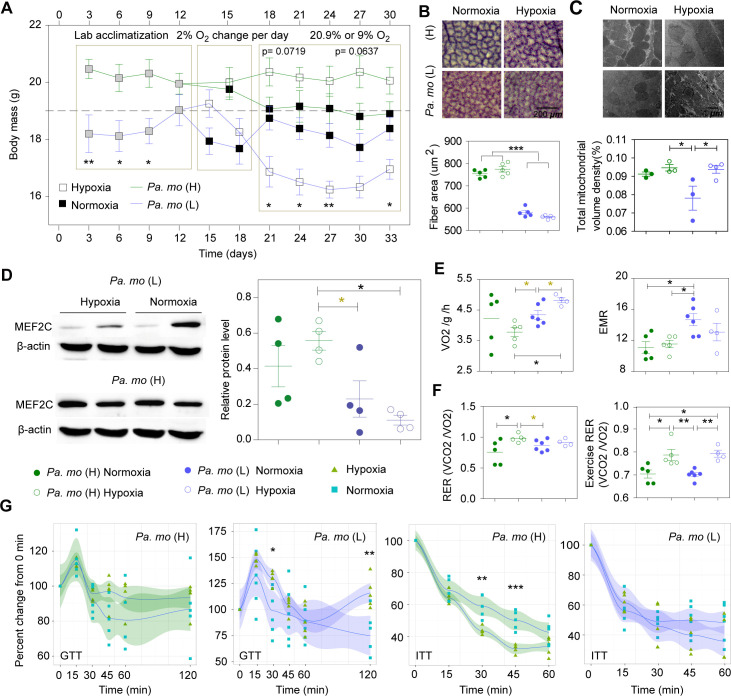
Muscle physiological plasticity and response to oxygen in high- and low-altitude tree sparrows.(A) Chronic hypoxia significantly reduced body weight of low-altitude tree sparrows but normoxia slightly decreased it in highlanders (n = 5 each). (B) Muscle mass was greater in high-altitude tree sparrows compared to lowlanders, which was not related to hypoxia(n = 5 each). (C) Mitochondrial volume densities were greater in high-altitude tree sparrow and hypoxia lowlanders (n = 3 each) compared to normoxia counterparts (n = 4). (D) High-altitude tree sparrow had a significant higher protein levels of MEF2C in hypoxia compared to hypoxia and normoxia lowlanders (n = 4 each). (E) Hypoxia induced high RMR in low-altitude tree sparrows (n = 6 and 4 for RMR) but not highlanders (n = 5 each). (F) Hypoxia increased resting RER only in highlanders but exercise RER both in high- and low-altitude tree sparrows. (G) High-altitude tree sparrow improved insulin sensitivity in hypoxia compared to normoxia (n = 5 each). Hypoxia was unable to change insulin sensitivity but induced glucose intolerance and increased insulin contents in low-altitude tree sparrows (n = 6 and 5 for normoxia and hypoxia).